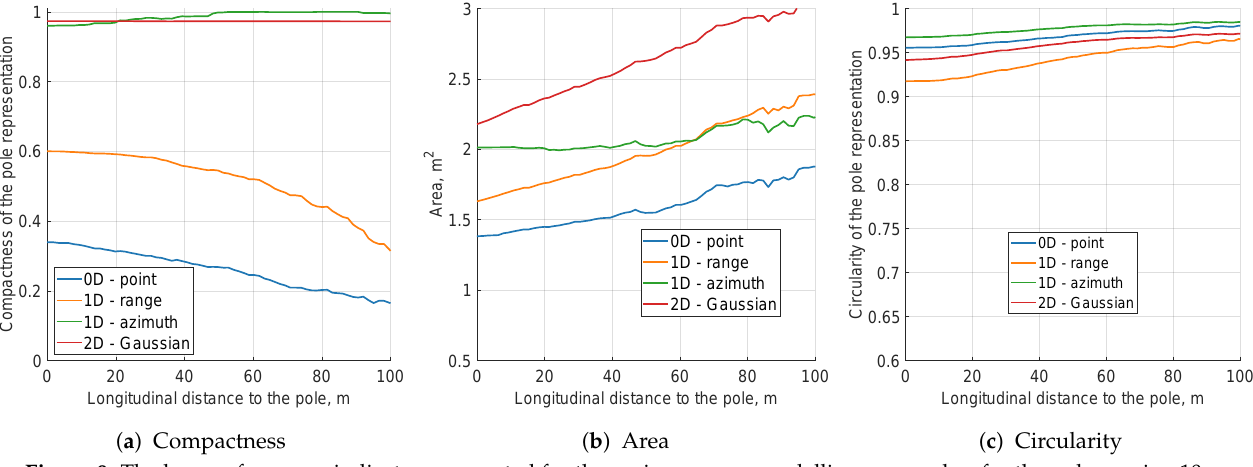
Figure 9. The key performance indicators computed for the various sensor modelling approaches for the pole moving 10 m laterally at a time. The scaling of this figure is the same as that of all other simulation KPI plots.